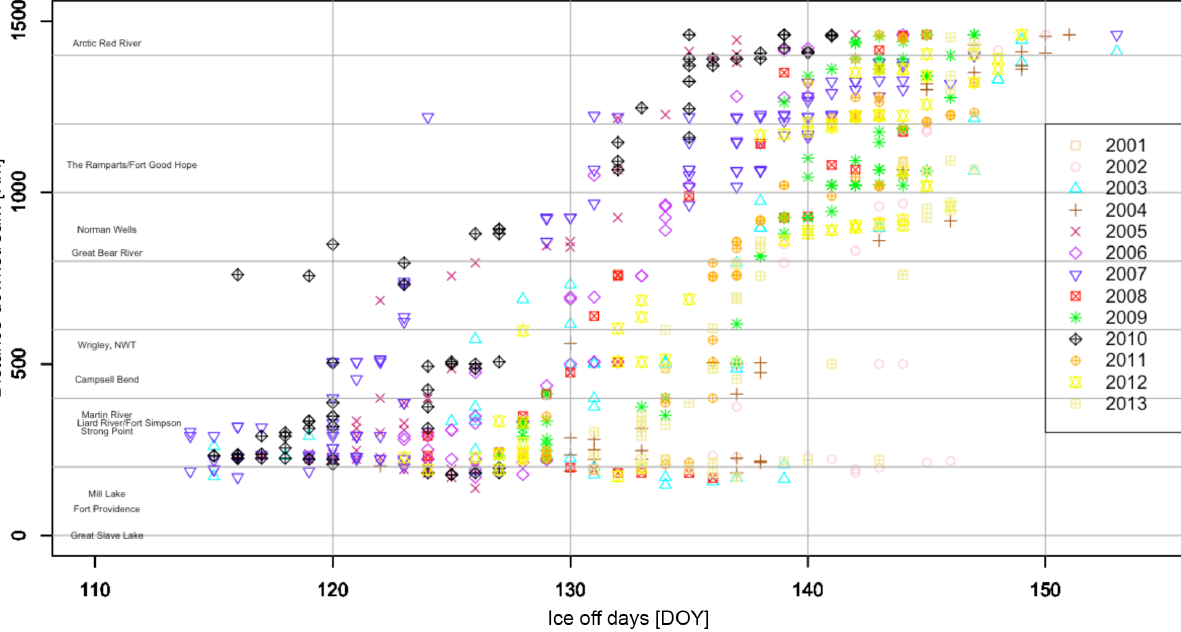
The Cryosphere, 10, 569–584, 2016